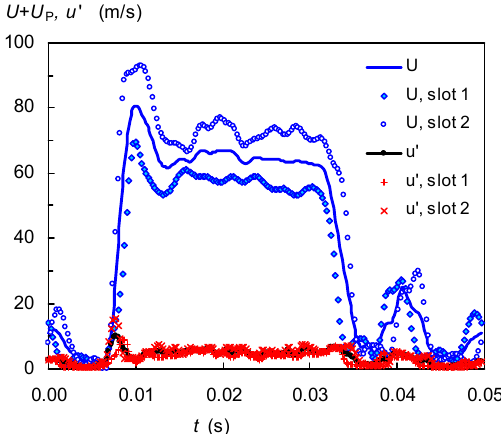
Fig. 4 . Centerline velocity during one cycle of the actuation at f = 20 Hz and duty cycle